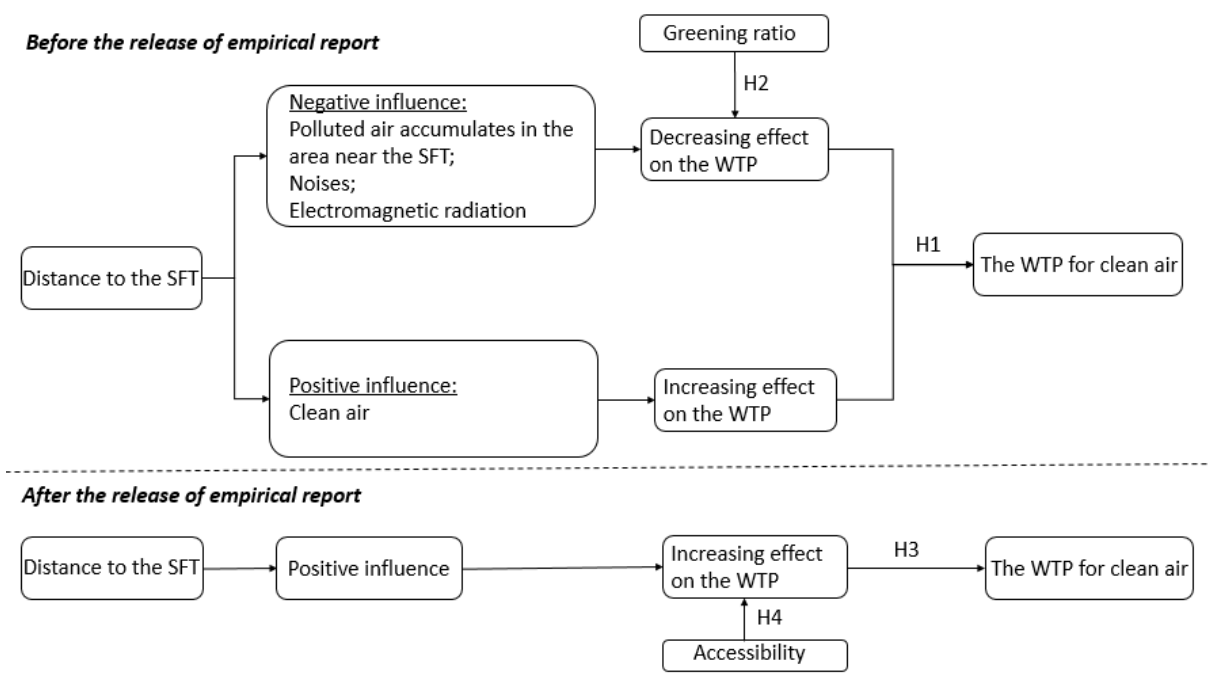
Figure 1. The proposed model (WTP: willingness to pay).